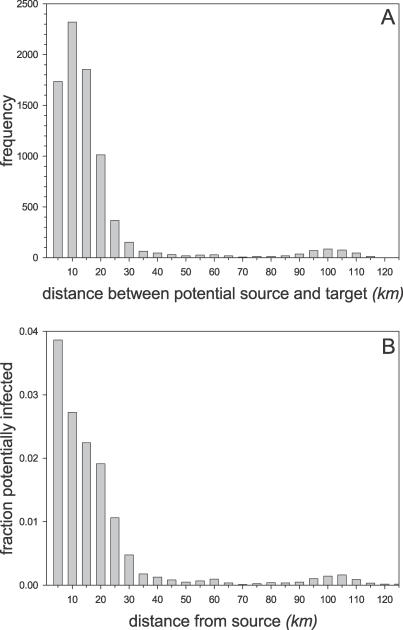
Distance Distribution of Potential Transmission Events(A) The frequency distribution of the distances of potential infection events. Notice that the majority of potential infections occur within a radius of 25 km around an infected farm.(B) The proportion of farms infected within different distance categories from a potential source farm, averaged over all possible source farms (i.e., over all farms confirmed positive during the 2003 epidemic).